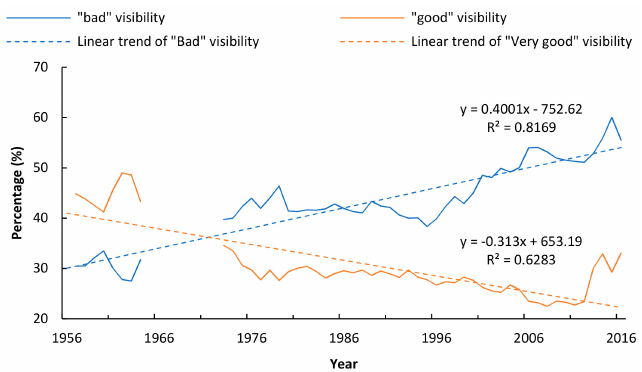
Figure 4. Annual mean ‘bad’ atmospheric visibility percentages (%) were less than 10 km (shown in left axis of y) from 1957 to 2016 in China’s 31 PCCs. Dash lines refer to the curves of linear regression for the corresponding lines of